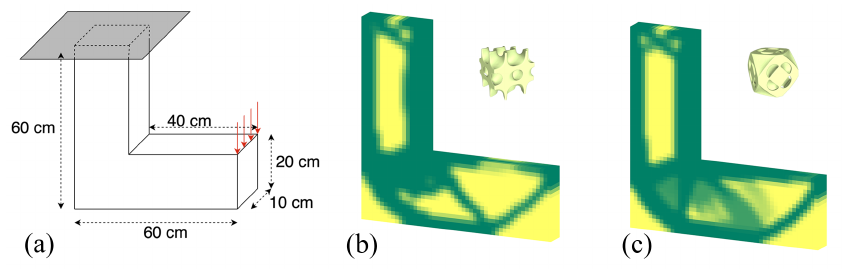
Figure 12. Optimal results of Case IV (L-shape Structure) with two different cellular material ar- chitectures: ( a ) Boundary condition and loading, ( b ) Optimized structure (compliance = 840) with orthotropic cellular material F 1 , ( c ) Optimum structure (compliance =1130) with isotropic cellular material F W